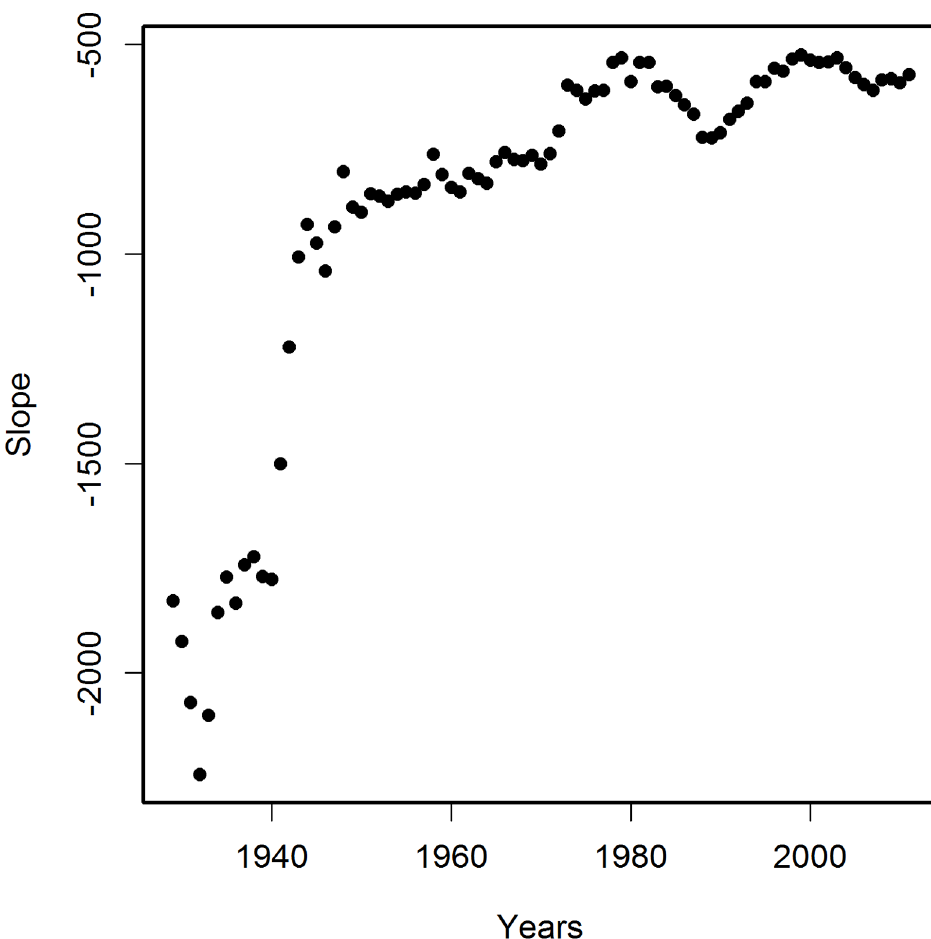
Fig 4. Variability in time of the slope of correlations of PCPI for each state with age-adjusted AD death rates (AADRs) for the respective states in 2005. Numbers of states as in legend to Fig 3.